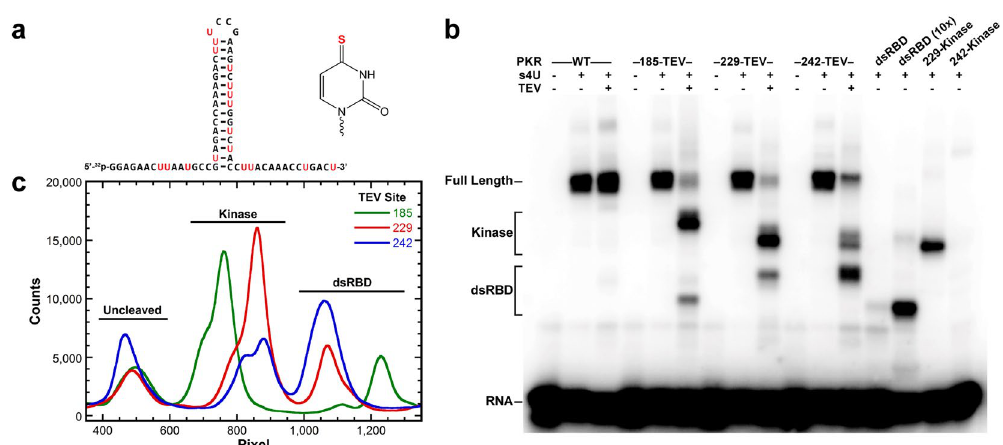
Figure 5. Crosslinking analysis of PKR binding to ss-dsRNA. ( a ) Secondary structure of the ss-dsRNA (15-15- 15) and chemical structure of 4-thiouridine. Modified uridines are highlighted in red and the sulfur responsible for photochemical crosslinking is highlighted in red in the 4-thiouridine structure. ( b ) Phosphorimager analysis of 32 P incorporation in RNA:protein complexes following crosslinking. Full length PKR constructs containing a TEV protease site and individual domains were crosslinked to radiolabeled ss-dsRNA. TEV cleavage was performed after the crosslinking reaction. The P1 ′ position of the cleavage site is indicated above the lanes. Samples contained 0.5 µ M RNA and 1 µ M protein. One sample of dsRBD contained 10 µ M protein (labeled 10x). Lanes labeled as ( − ) s4U contained unmodified ss-dsRNA. ( c ) Quantitation of RNA:protein adducts following TEV cleavage. Distributions were created by vertical integration of data from panel